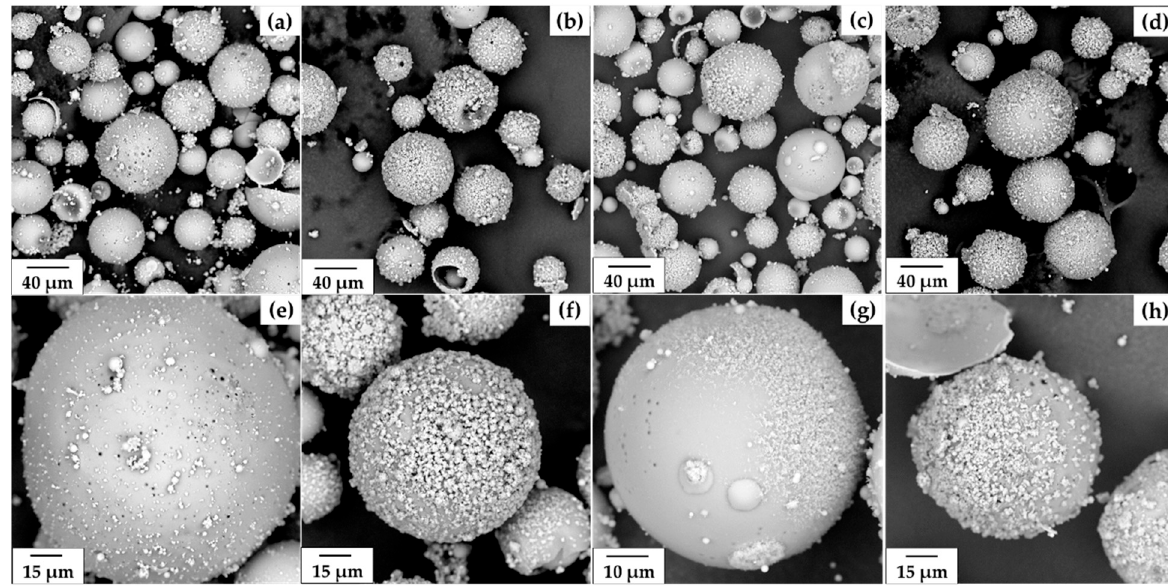
Figure 2. SEM images of cenospheres collected by centrifugal method using the centrifugal speeds of ( a , e ) 1000, ( b , f ) 2000, ( c , g ) 3000, and ( d , h ) 4000 rpm, and the centrifugal time of 10 min.